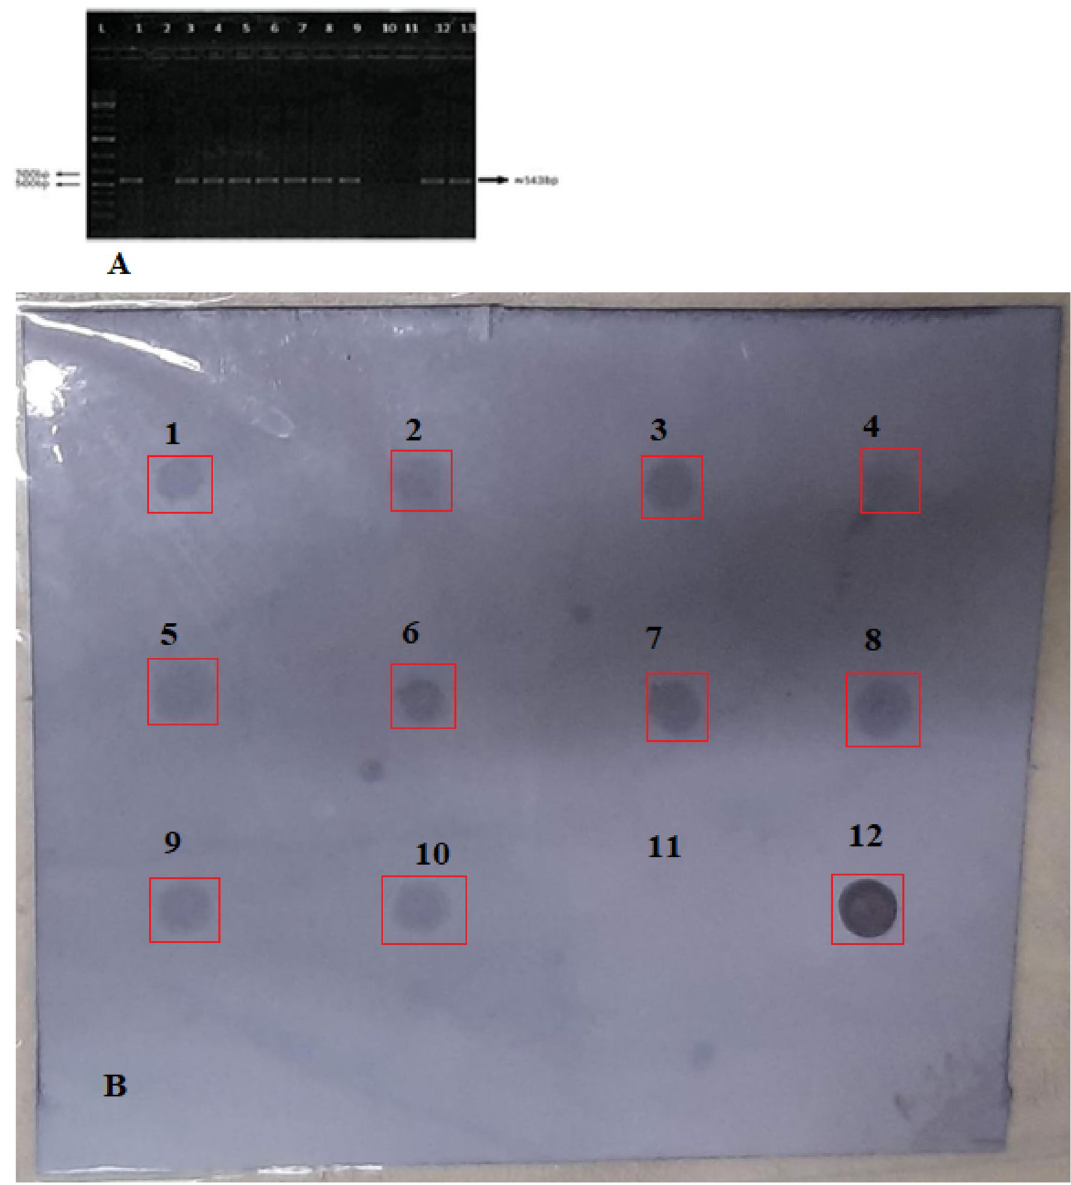
Figure 5. ( A ) PCR amplifications of positive plants indicating integration of ThSyGII(CEMB-SIG2) with 543 bp amplicon. Lane L ladder, 100 bp, lane 1 representing postive control, lane 2, negative control, lanes 3,4,5,6,7,8,9,12,13 show PCR positive lines while lanes 10 & 11 indicate PCR negative plants. The gel picture was cropped to exclude un-required raw gel bands not included in our study. The original uncropped gel pic was provided in supplementary information file as figure S-5A ( B ). Dotbot analysis inciating the blotting of all red boxes enclosed labelled selected PCR positive tarnsegnic lines are shown for all positive and negative control lines. The blotting spots 1–10 showed all transgenic sugarcane lines while 11 indicated negative control and 12 spot shows positive control. The membrane was covered with plastic to avoid further membrane blackening. Paint software tool was used for labelling and cropping targeted transgenic lines. The uncropped membrane edges shown RNA dot blot picture was also shown as supplementary part as figures S-5A & Stem mediated combinatorial promoters (PolyUbi + CmYMV) driven expression levels in trans‑ genic sugarcane stalks. Transgenic sugarcane lines harboring ThSyGII intimated incompatible expression levels both in leaf and stem tissues. Our results indicate that all lines especially SIP36, SIP34, SIP37,SIP48 and SIP 46 showed increased ThSyGII expression levels. Highest difference level was observed in stem and leaf tissues in SIP46 stood at 77.2% more than leaf tissues. Percent expression level enhancement in transgenic lines occur- ring in culms was calculated separated and represented in Fig. 7. The percentage increase of ThSyGII expression level in SIP34, SIP36, SIP37, SIP40, SIP41, SIP45 and SIP48 was stood as 60%, 26.8%, 30.7%, 33.3%, 32.1%,